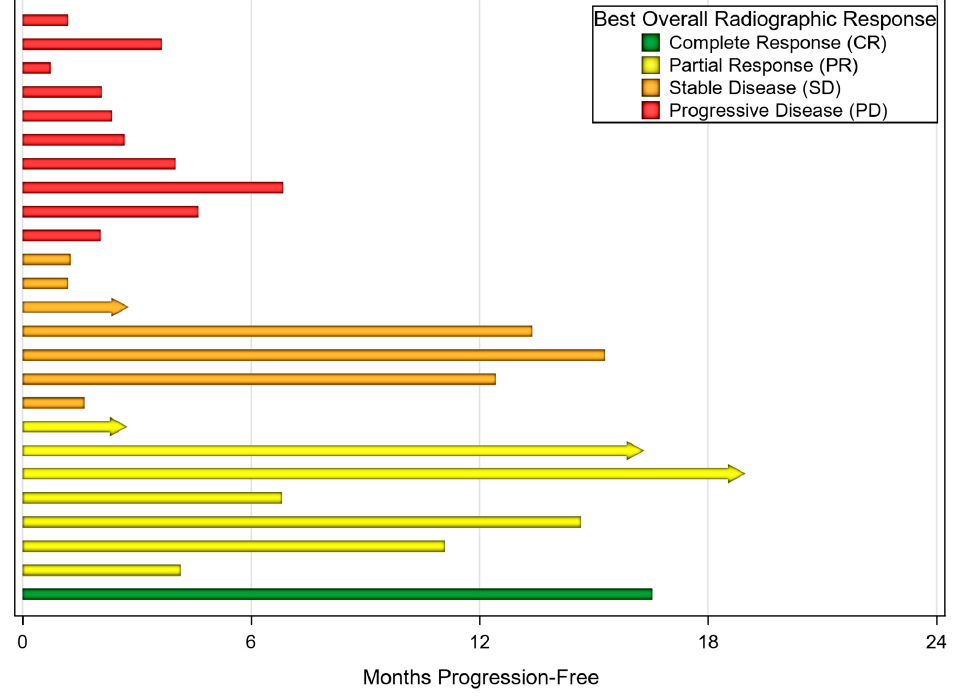
Figure 1. Month progression-free grouped by best overall radiographic response in patients with undifferentiated pleomorphic sarcoma (UPS) ( n = 25). Arrows indicate ongoing